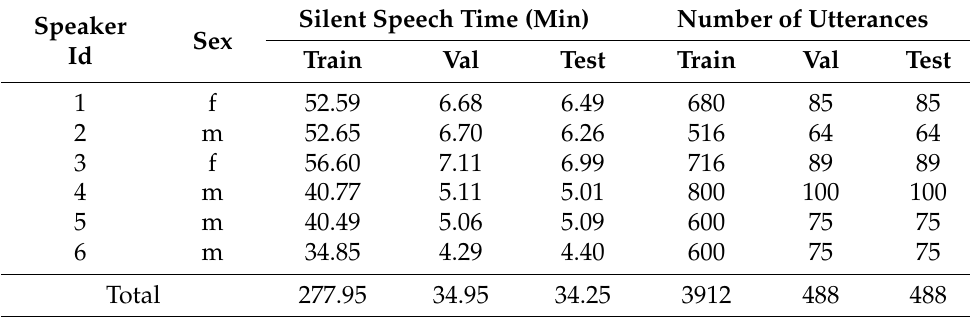
Table 2. Statistics of the sEMG _ Mandarin Dataset.